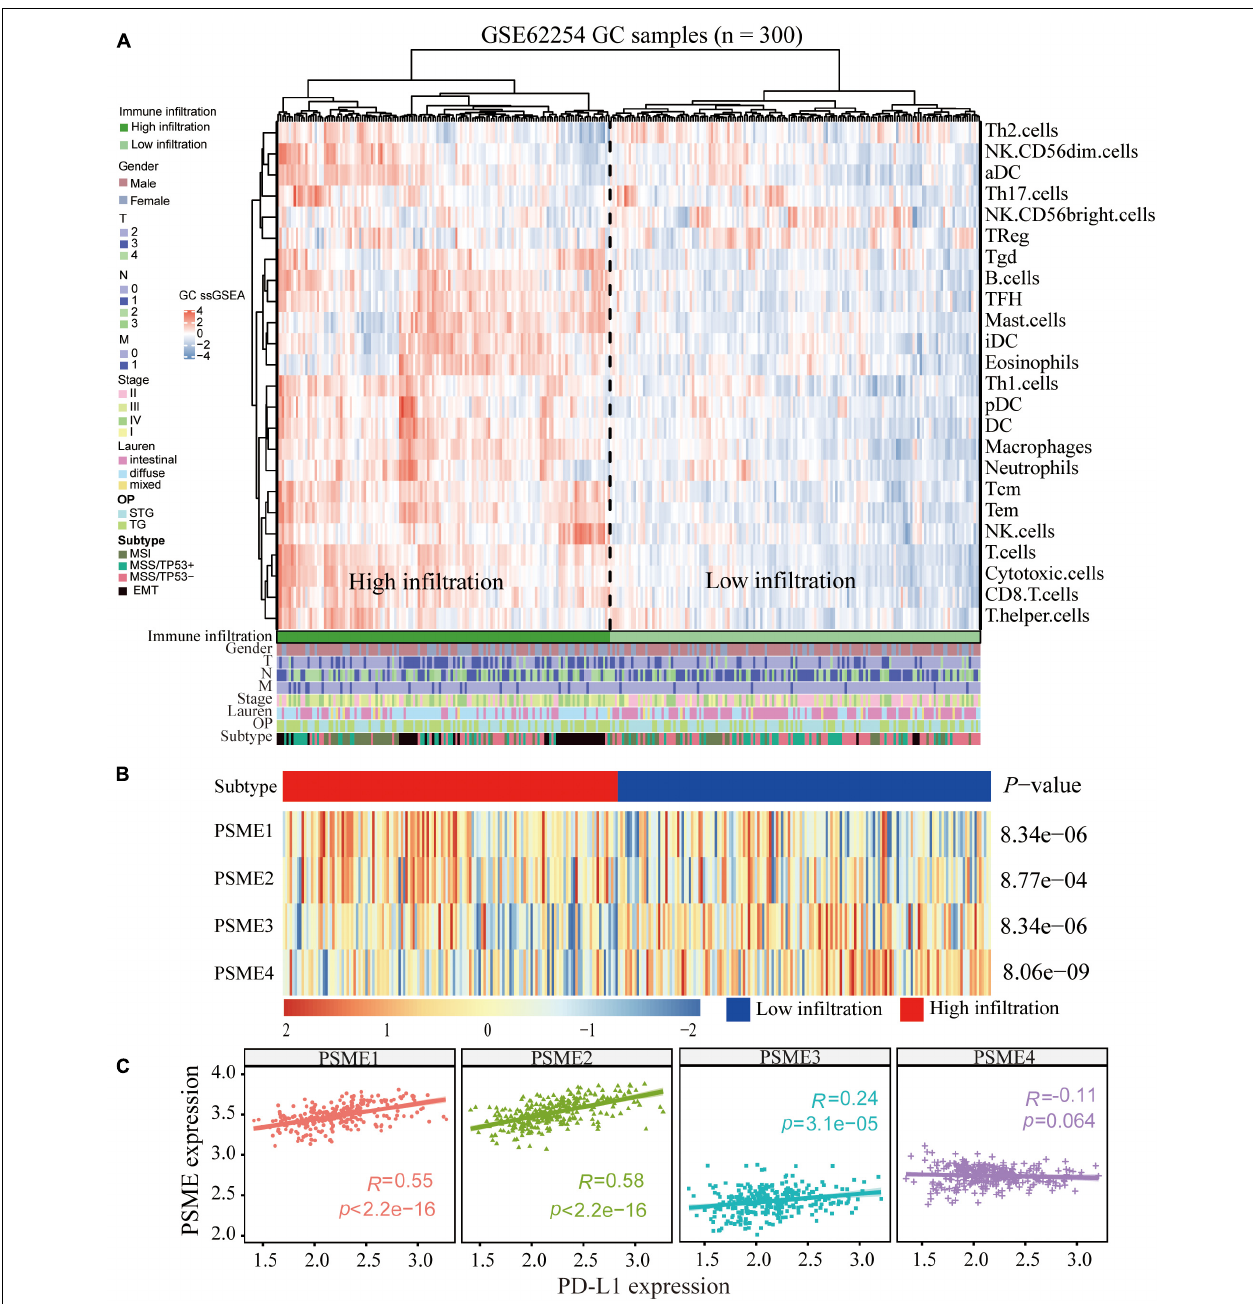
FIGURE 10 | Correlation between PSME genes and immune infiltration. (A) Immune landscape of GC and unsupervised clustering of 300 patients from the GSE62254 cohort. Molecular subtype, post-operation type, number of positive nodes, Lauren classification, stage, TNM stage, age, and gender were annotated in the higher panel. Hierarchical clustering was performed with Euclidean distance and Ward linkage. (B) The relative expression of PSME genes in higher and lower immune infiltration patients with GC. (C) The correlation between PSME genes’ expression and PD-L1 in GC patients in GSE62254 cohort.